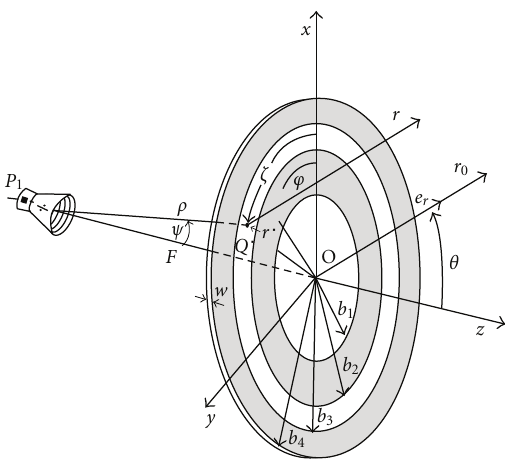
Figure 3: Radiation geometry of FZP lens antenna. Figure 4: Binary FZP lens of FZPA-M-10 designed at microwave frequency of 90 GHz with all even zones covered by thin metal (in grey) printed on dielectric substrate (in light